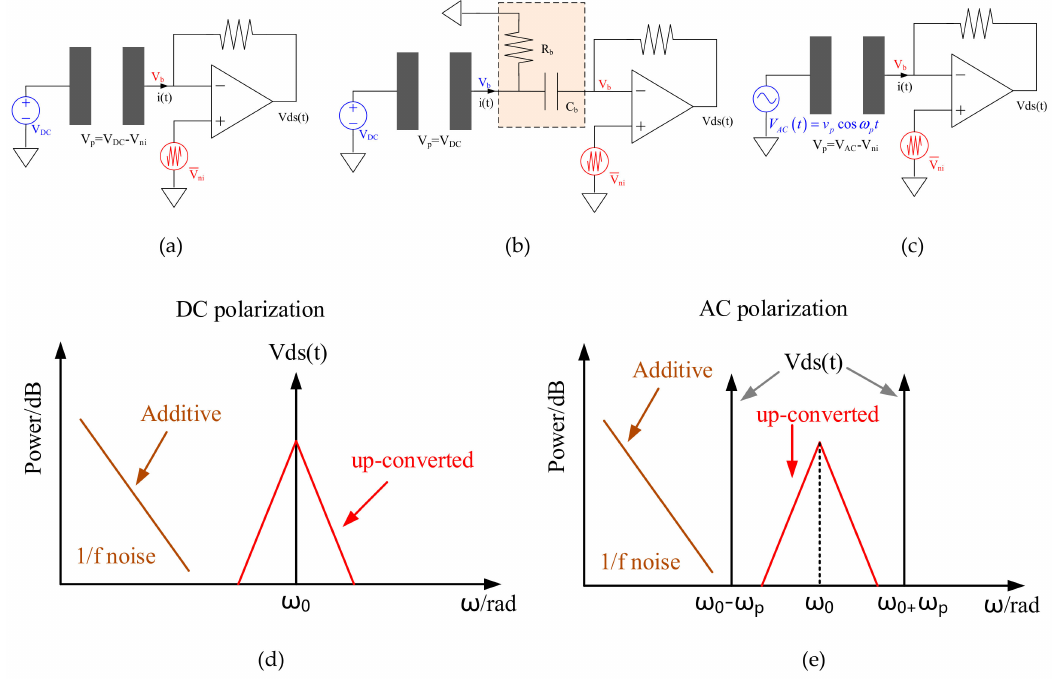
Figure 3. Illustrations of MEMS sense comb with three polarization modes ( a ) DC polarization; ( b ) DC polarization with R-C passive filter; ( c ) AC polarization and TIA output spectrum with; ( d ) DC and ( e ) AC